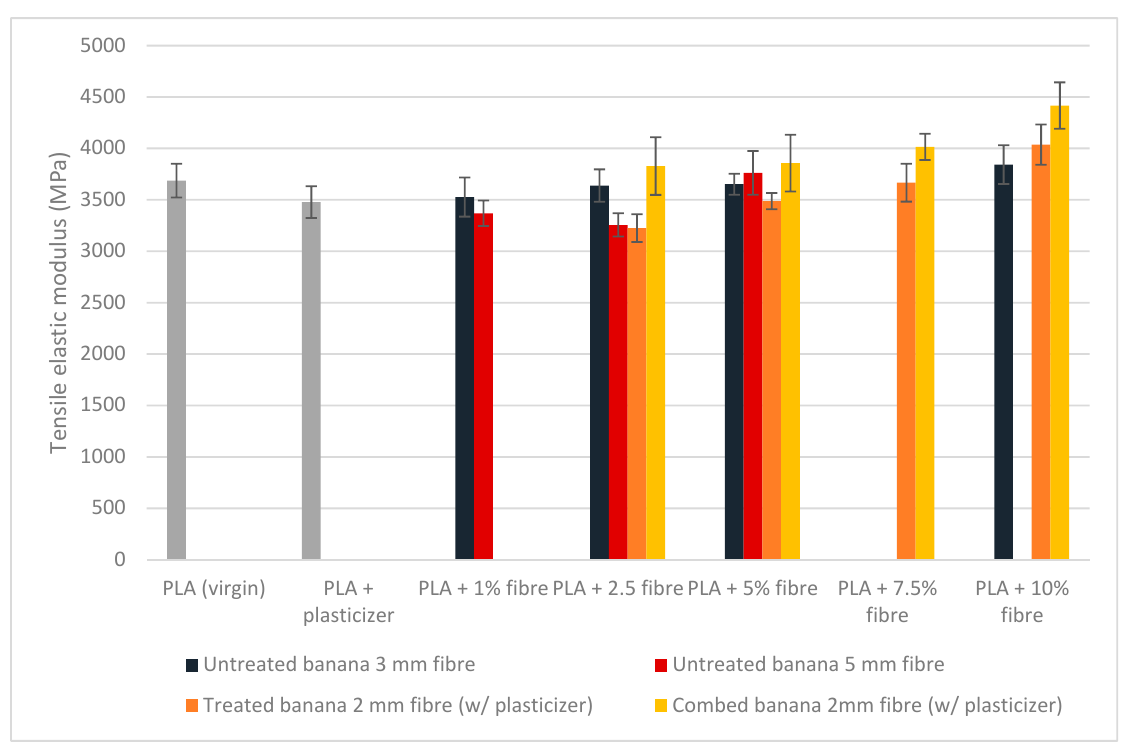
Figure 2 . Tensile elastic modulus, PLA Ingeo 4032 D with different fiber percentages. Figure 2. Tensile elastic modulus, PLA Ingeo 4032 D with different fiber percentages. Treated and combed banana fiber compounds had 7 wt % plasticizer, while the oth- Treated and combed banana fiber compounds had 7 wt % plasticizer, while the ers did not. The plasticizer content decreases the mechanical properties of the compounds, so they cannot be compared without taking this into account. Despite this, composites with untreated combed banana fibers had the highest tensile elastic modulus and the sam- ples did not significantly degrade during the processing with PLA at 180–190 °C. For this